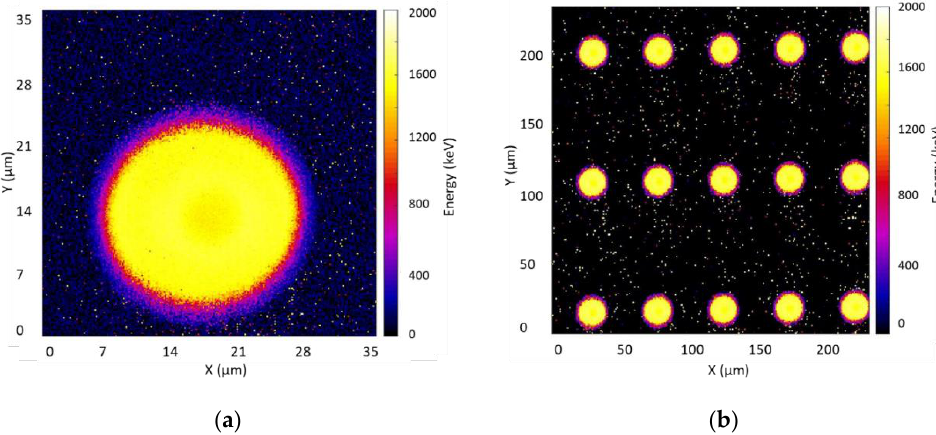
Figure 11. Response of the array of the 10-µm-thick free-standing Mushroom microdosimeter embedded in polyimide to a 5.5 MeV He 2+ ion microbeam ( a ) Median energy map of a zoomed-in scan of a single SV and ( b ) a full array at 10 V bias [25].